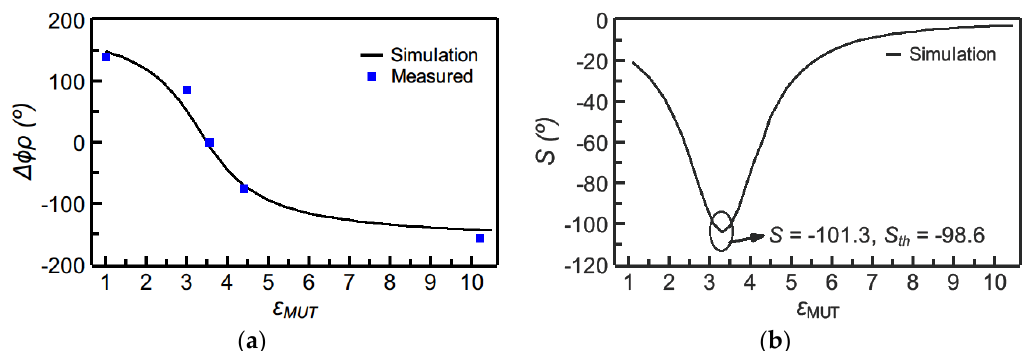
Figure 11. Photograph of the designed and fabricated reflective-mode phase-variation sensor based on a low-impedance 90° line section and a high-impedance 90° open-ended sensing, with reference sample the uncoated Rogers 4003C substrate (with ε MUT = 3.55). Dimensions (in mm) are: W d = 7.5, l d = 12.8, W S = 0.235 and l S = 13.5. Reprinted with permission from [64].